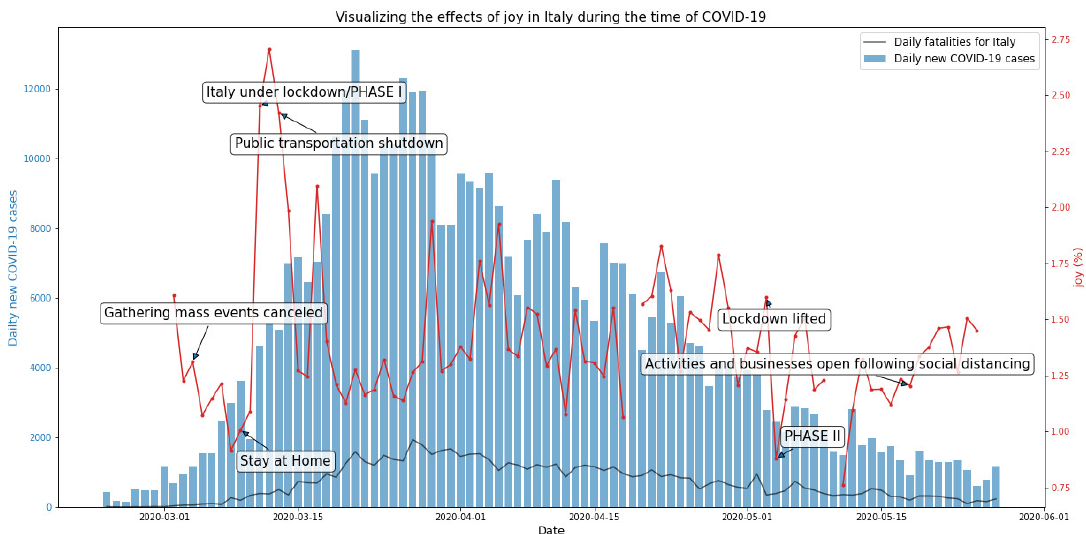
Figure 3. Anger-related tweets in Italy during the first wave of the COVID-19 pandemic.